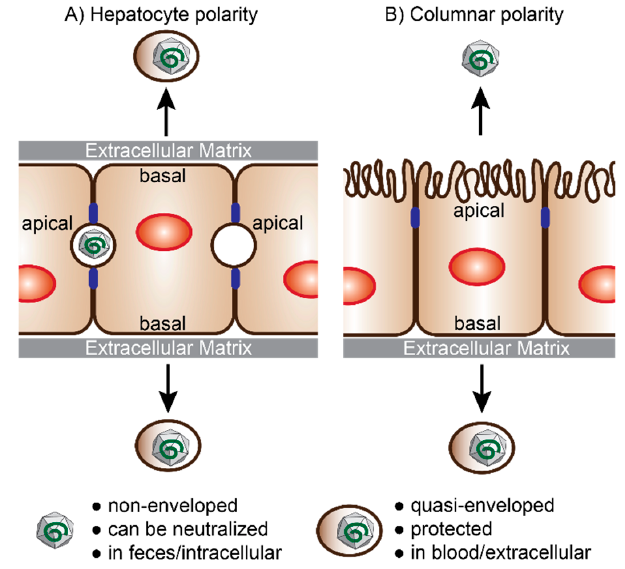
Figure 2. Cell polarity and hepatitis E virus (HEV) secretion. HEV particle release from hepatocytes with ( A ) complex hepatocyte or ( B ) columnar polarity. Blue boxes are tight junctions separating apical and basal membranes. Adapted from the work of [22].